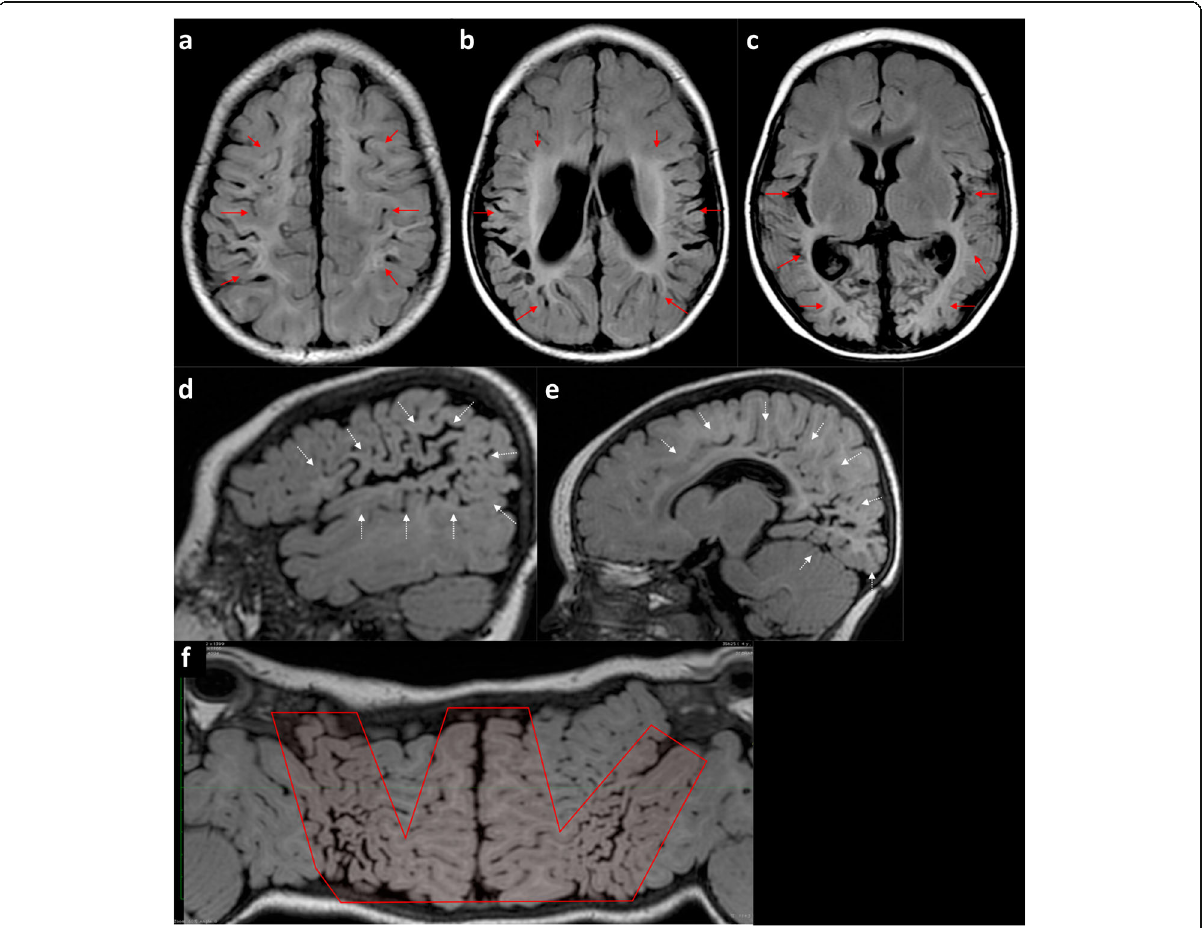
Fig. 12 a – f A 1-year-old boy who sustained a previous partial-prolonged hypoxic-ischaemic injury at term gestation. Sequential axial FLAIR images ( a – c ) from the vertex to the level of the lateral ventricles demonstrate volume loss with ulegyria and underlying white matter abnormal high signal affecting the watershed continuum in order from anterior, through parasagittal and peri-Sylvian to posterior (solid red arrows). d , e Sequential sagittal FLAIR images from lateral to medial demonstrate the same volume loss and underlying abnormal signal involving the parasagittal, peri-Sylvian and posterior watershed as a continuum (dotted white arrows). f Mercator map overview of the cerebral surface created from a curved reconstruction of 3DT1 images confirms atrophy of the watershed as a continuum from anterior, through parasagittal and peri-Sylvian to posterior (inside schematic ‘ W ’ )